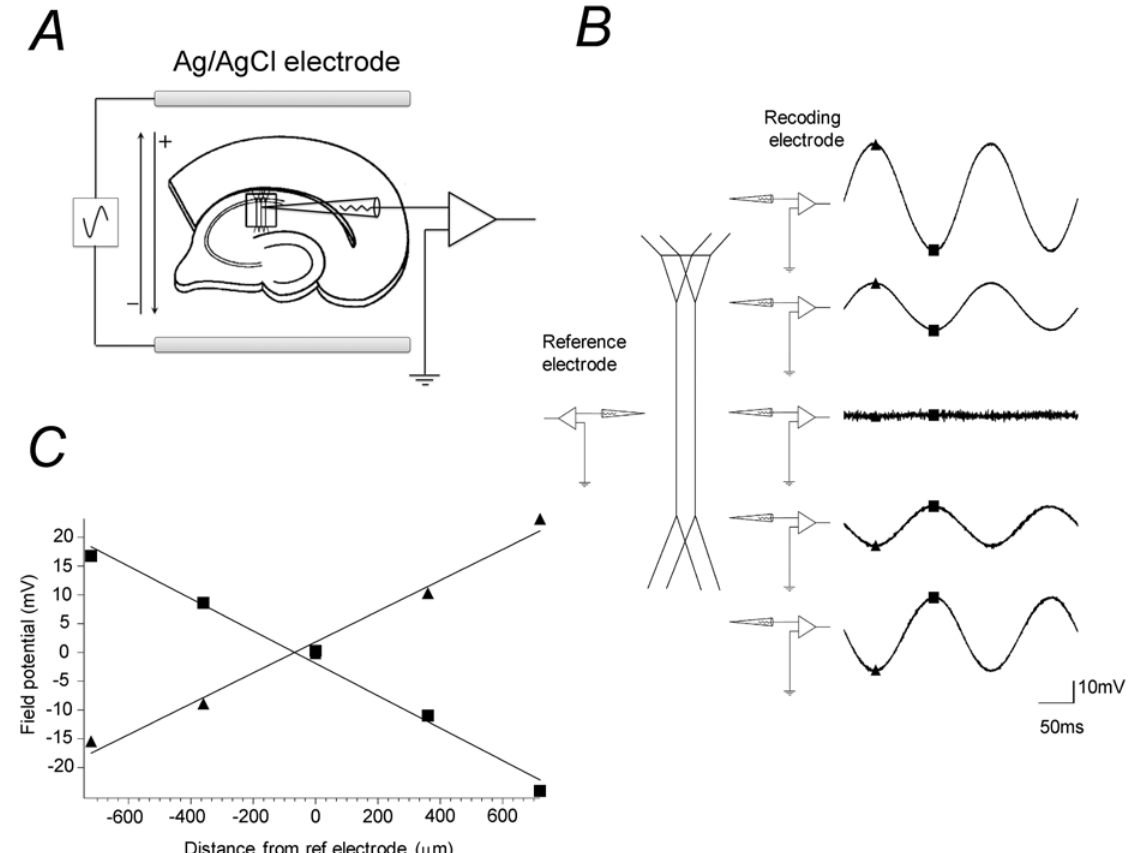
Fig 2. Sinusoidal electrical field stimulation. ( A ) Electric current was applied with a pair of Ag/AgCl electrodes placed 5 mm apart in parallel on the bottom of a submerge type recording chamber. A piece of hippocampal slice preparation was placed between the electrodes. A sinusoidal wave form was generated using in-house developed software run on a PC with a 12-bit digital-to-analog converter. The voltage output was electrically isolated and converted to current using a voltage-to-current converter. ( B ) Examples of extracellular field potential recorded from the CA1 area of a slice preparation. Field potential was recorded at 360 μ m interval across the CA1 region from the basal to apical dendrite during the passage of 6 Hz sinusoidal current with a glass pipette inserted into the tissue of the slice. The potential was measured with respect to a reference electrode placed at the middle of str. radiatum throughout the recording. ( C ) Peak values of extracellular field potential at the top and bottom of the stimulation plotted against the location of the electrode. With our setup arrangement, the field intensity was uniform along the somato-dendritic axis and was independent of whether the recording electrode was inserted into the slice or was placed outside of the slice. The peak intensity of the sinusoidal electric field stimulation was 27.8 mV/mm in this particular case. Unless specified otherwise, the frequency of the sinusoidal wave was 4 Hz (more precisely 3.79 Hz or 3.95